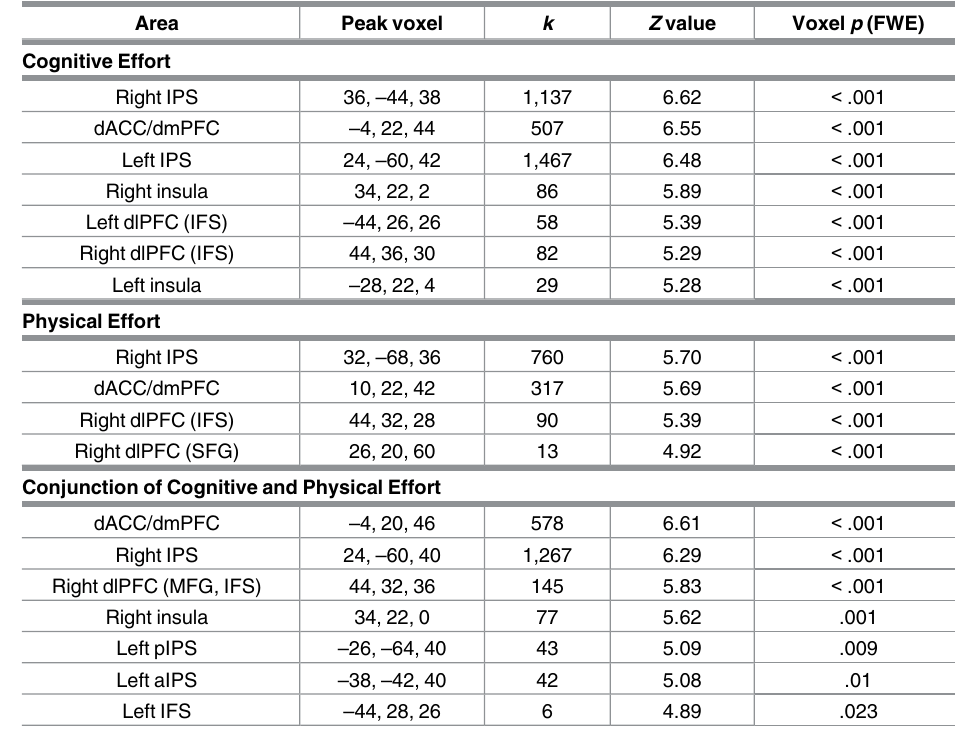
Table 1. Areas sensitive to the SV difference between the chosen option and baseline for (A) cogni- tive effort, (B) physical effort, and (C) the conjunction of both domains. Clusters are significantat a voxel-wise thresholdof p < .05, corrected for family-wise error. Coordinates are given in MontrealNeurological Institute (MNI) space. aIPS, anterior intraparietal sulcus; pIPS, posterior intraparietal sulcus; dACC, dorsal anterior cingulatecortex; dmPFC, dorsomedial prefrontalcortex; dlPFC, dorsolateralprefrontalcortex; MFG, middlefrontal gyrus; SFG, superiorfrontal gyrus; IFS, inferior frontal sulcus. Area Peak voxel k Z value Voxel p (FWE) Cognitive